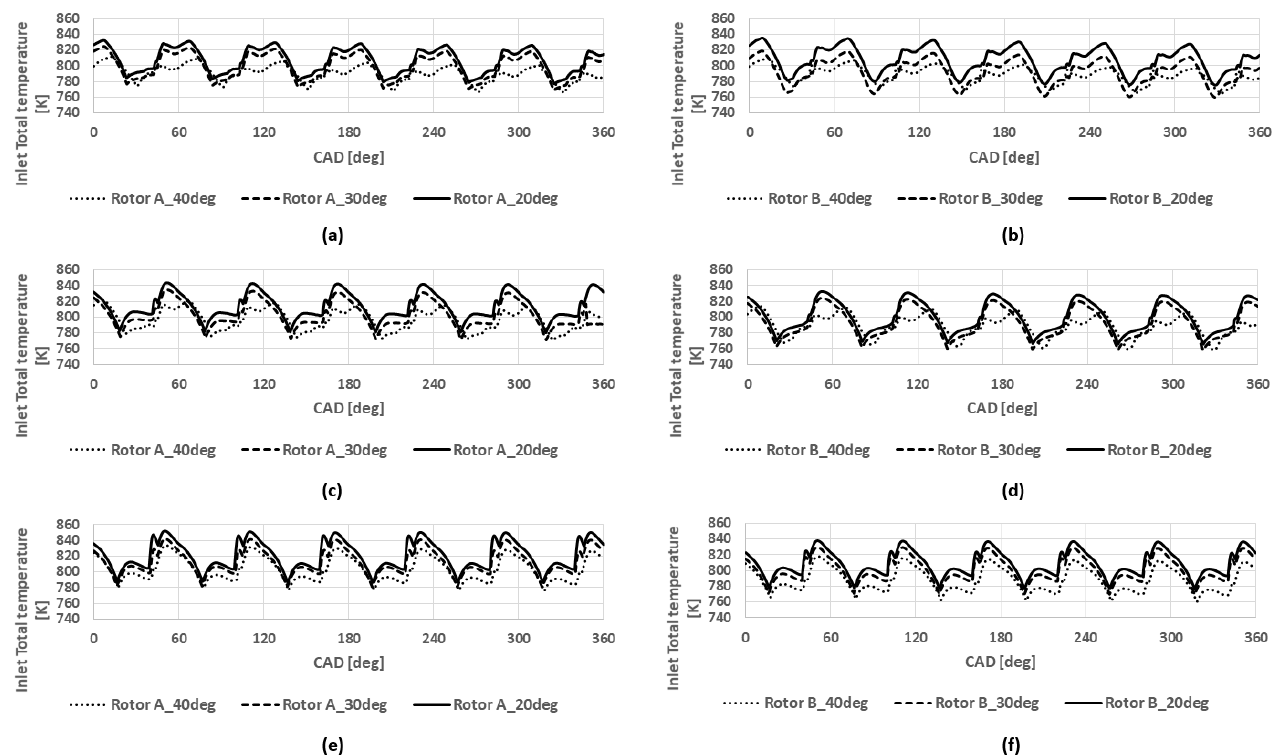
Figure 22. The variations of the area-averaged total temperature at the inlet to the first-stage rotor during the single revolution of the crankshaft for three different turbine speeds, VTG vane positions and rotor geometries: ( a ) rotor A at 60,000 rpm, ( b ) rotor B at 60,000 rpm, ( c ) rotor A at 50,000 rpm, ( d ) rotor B at 50,000 rpm, ( e ) rotor A at 40,000 rpm, ( f ) rotor B at 40,000 rpm.